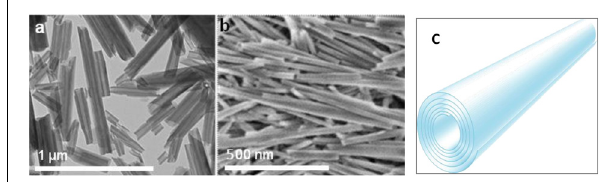
FIGURE 1 | A TEM and SEM image of halloysite nanotubes (a,b) . A scheme of rolled clay (c)